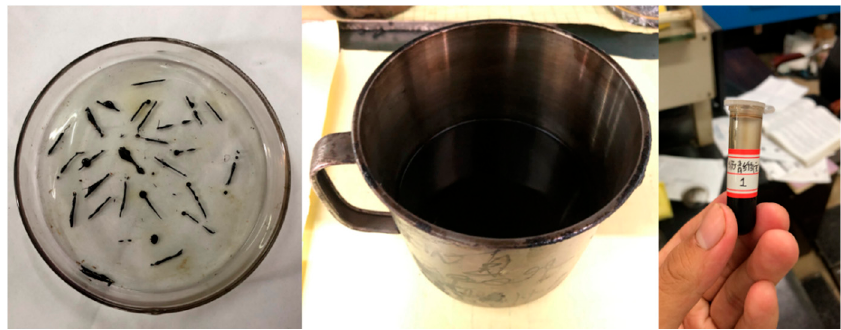
Figure 8. Extraction and storage of asphalt binder coated on Dramix steel fibers. Materials 2018 , 11 , x FOR PEER REVIEW